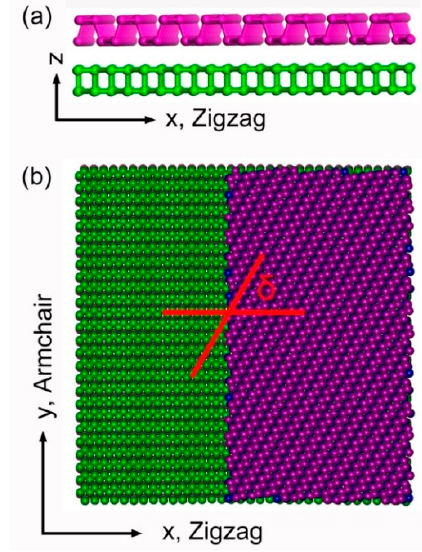
Figure 1. Atomic structure of double-layer black phosphorus (DLBP) crystal with a stacking angle difference δ = 60° from ( a ) side view and ( b ) top view. The atoms colored by green and purple are in the bottom and top layer, respectively. For a better view, only half of the top layer is shown in ( b ).